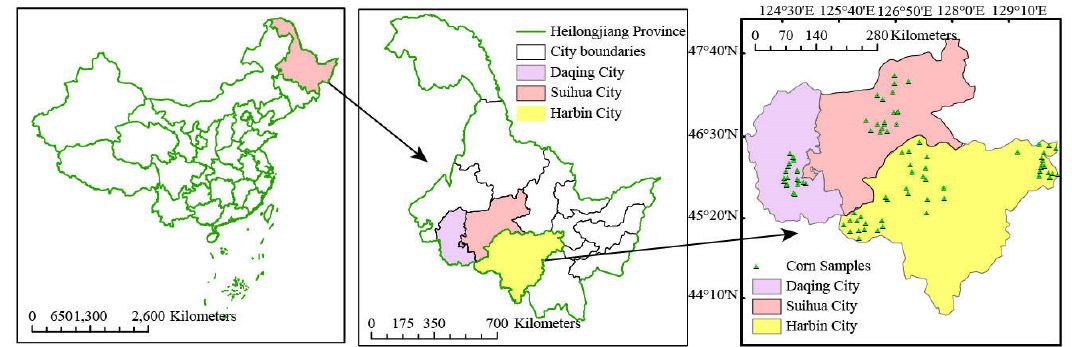
Figure 7. Distribution of the sampling locations.